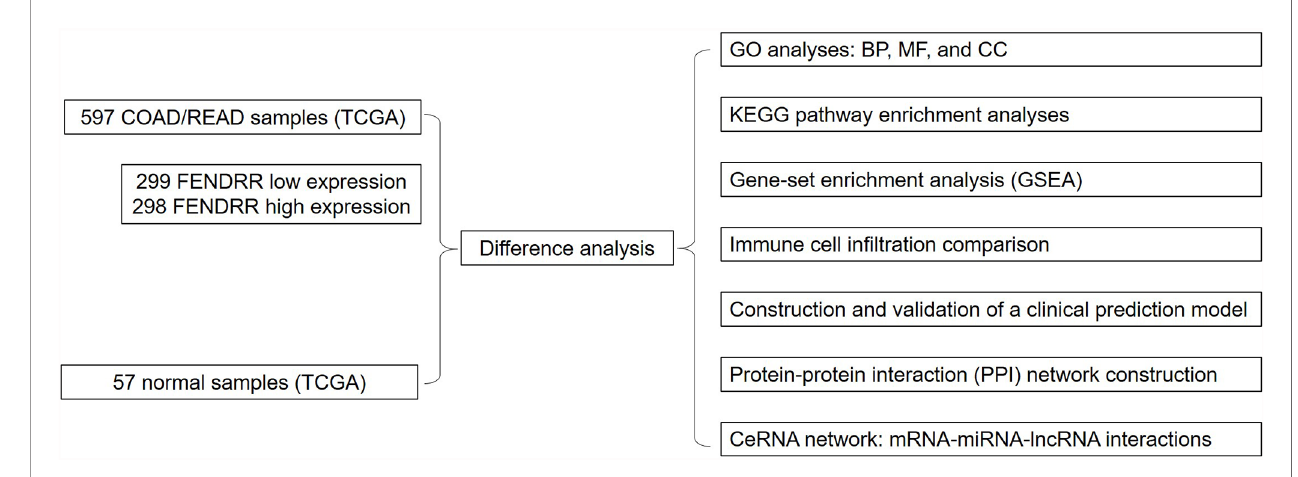
FIGURE 1 | The fl owchart of all analysis processes.